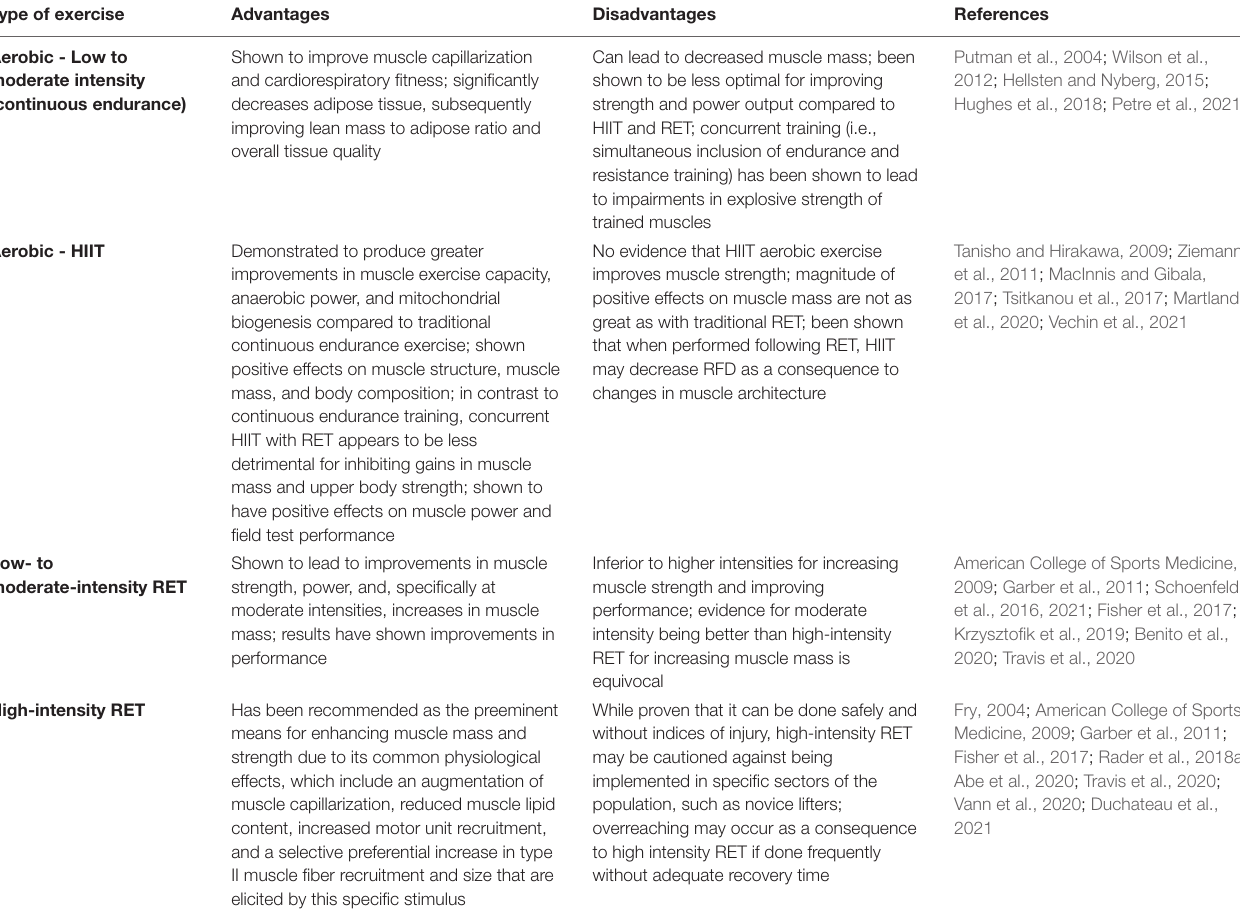
TABLE 3 | Different training modalities for improving MQ in young, healthy